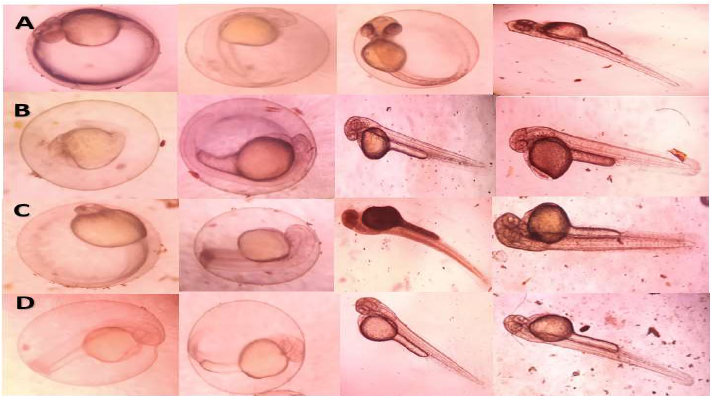
Figure 12. Representative images of embryos exposed to Pantoea stewartii -synthesized silver nanoparticles (Ag NPs) at 120 hpf: ( A )—10 µ g/mL; ( B )—20 µ g/mL; ( C )—30 µ g/mL; and ( D )—50 µ g/mL. 2.12. Toxicity Studies on Embryonic Zebrafish Exposed to Priestia aryabhattai-Mediated Ag NPs Priestia aryabhattai -mediated Ag NPs resulted in minimal (less than 20%) mortality in embryos 48 h after treatment. There was no mortality in controls and groups treated with lower concentrations (10 and 20 µ g/mL). The LC 50 and LC 90 values were 101.032 Figure 13).